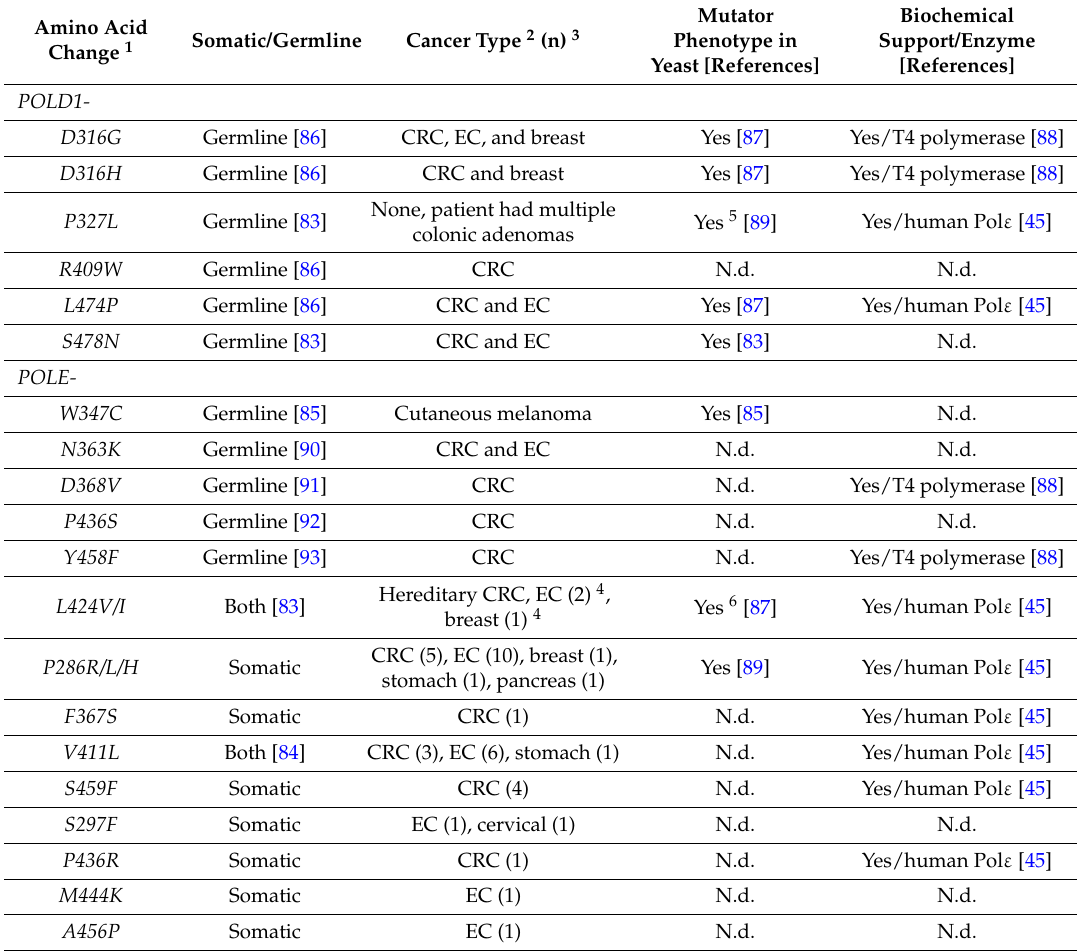
Table 1. Pathogenic replicative polymerase